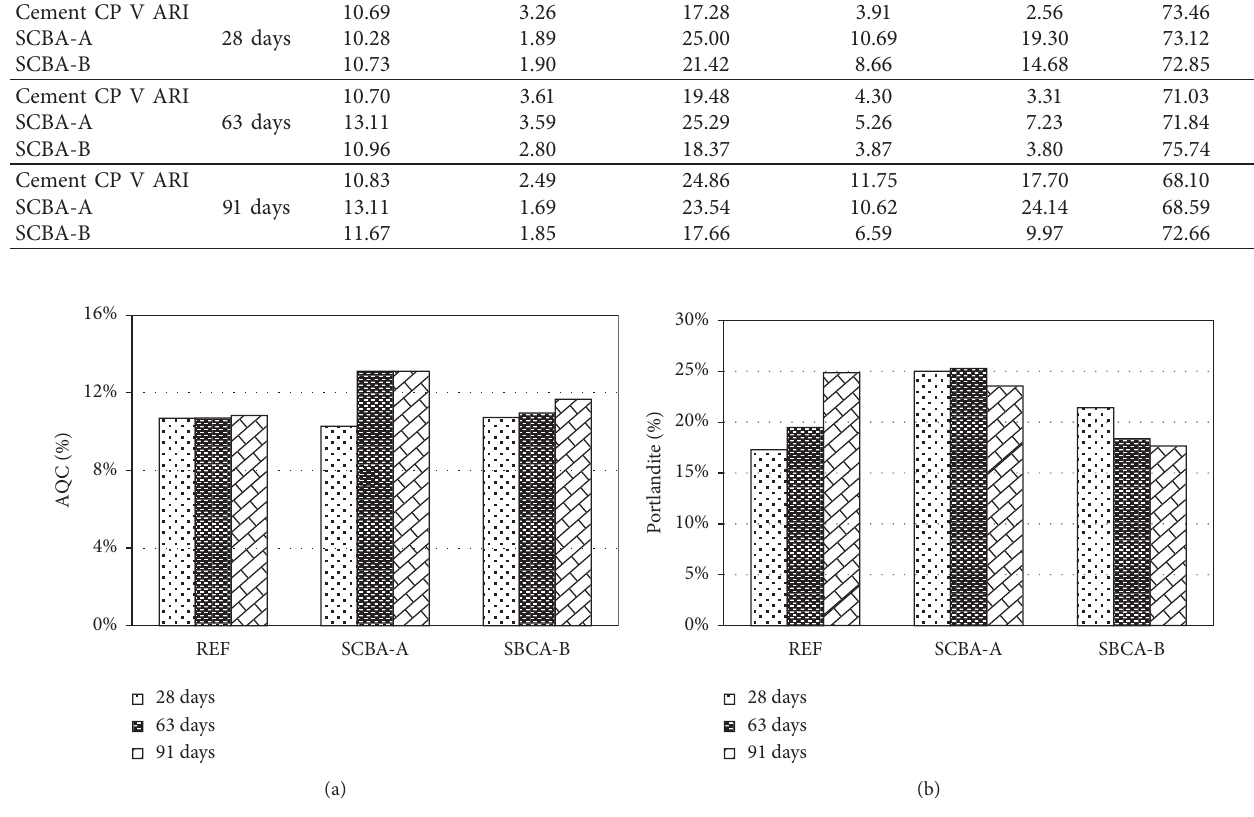
Table 3: Summary of chemically combined water and portlandite (AQC and Ca(OH) Cement paste